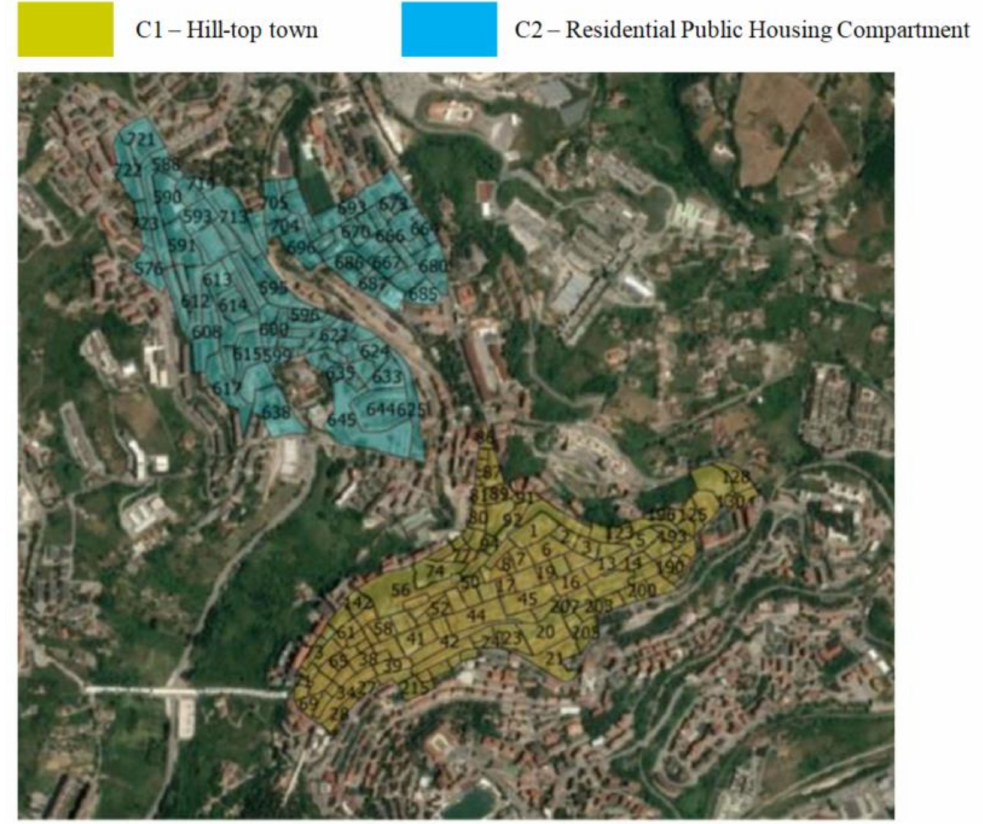
Figure 2. Compartments overview and census tracts: (yellow) old town center and (blue) residential compartments.